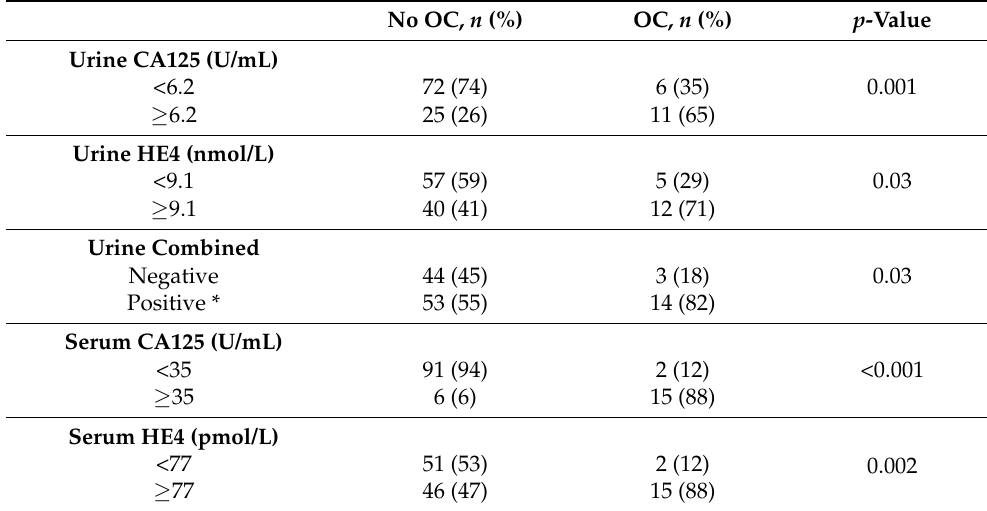
Table 2. Two-by-two cross-tabulations of serum and urine CA125 and HE4 and ovarian cancer. No OC, n (%) OC, n (%) p -Value Urine CA125 (U/mL)